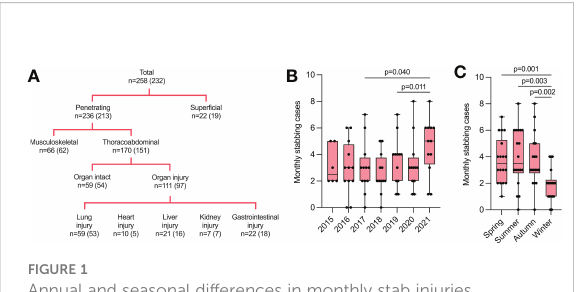
FIGURE 1 Annual and seasonal differences in monthly stab injuries. (A) Characteristics of included stab injuries divided by penetrating vs. super fi cial, thoracoabdominal vs. musculoskeletal, and organ injuries vs. non-organ injuries. Numbers in brackets show the number of cases included in statistical analysis (for details, please see Materials and Methods). (B) Monthly stab injury cases between 2015 and 2021. Individual data points represent the number of stabbing cases per month for indicated years. (C) Monthly stab injury cases between 2016 and 2021 divided by seasons. Individual data points represent the number of stabbing cases per month for indicated seasons. Data are presented as median box plots with interquartile range and whiskers from minimum to maximum.